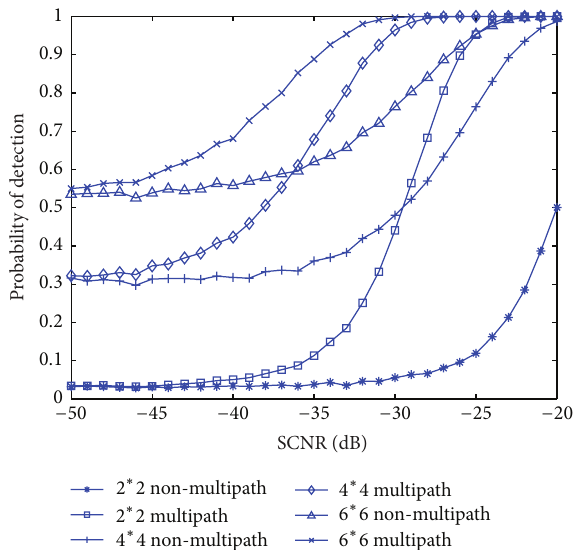
Figure 7: Detection performance of GLRT detector with different numbers.